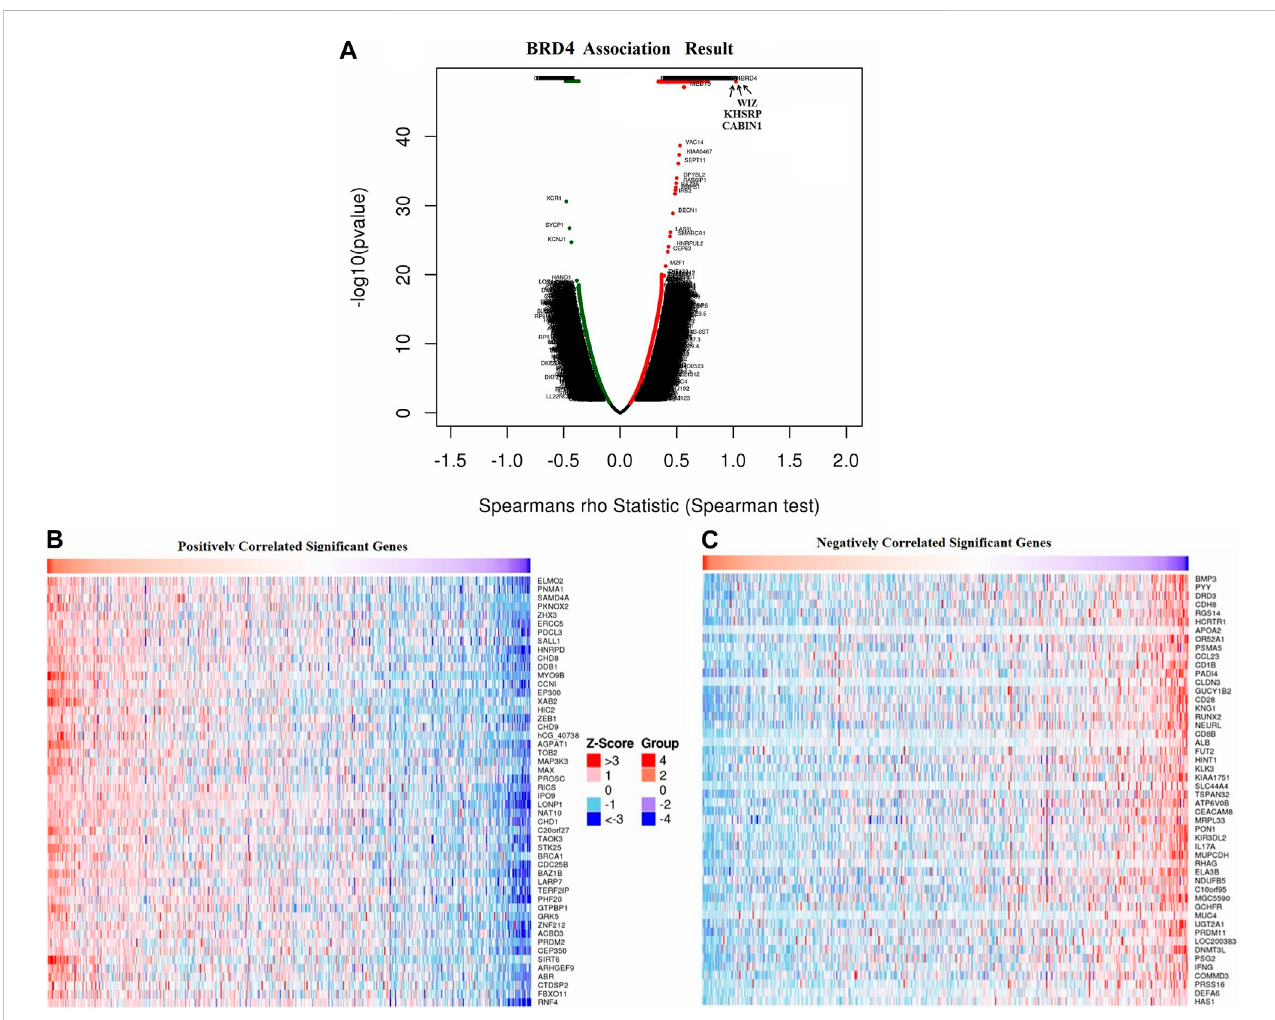
FIGURE 9 Differentially expressed genes associated with BRD4 in GBM samples in LinkedOmics database. (A) The correlation between BRD4 and differentially expressed genes in GBM was analyzed by Spearman test. (B – C) Heatmaps showed the positive and negative correlation genes (top 50) with BRD4 in GBM.